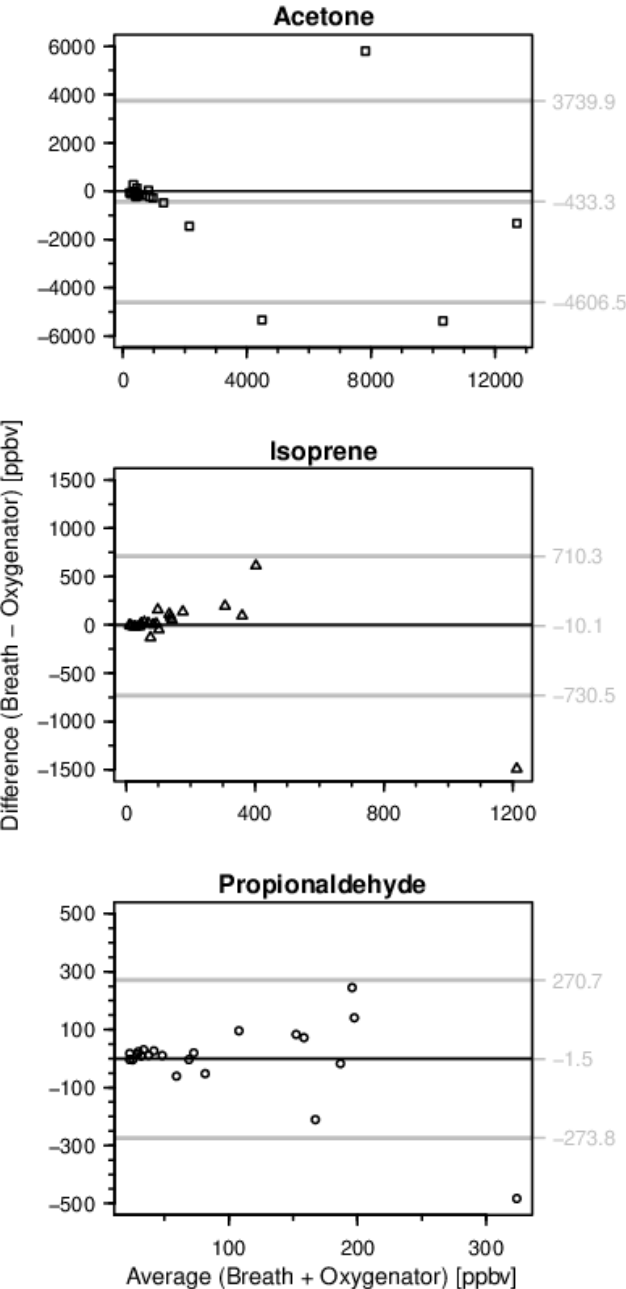
Figure 2. Bland-Altman plot of exhaled breath and oxygenator outflow gas VOC content. Concentrations of acetone, isoprene, and propionaldehyde in breath and extracorporeal membrane oxygenator gas on day one and three of measurements are included. For moderate VOC concentrations a generally good agreement of VOC concentrations in breath and oxygenator gas was observable. The grey lines represent the limits of agreement (average difference ± 1.96 standard deviation of the difference).